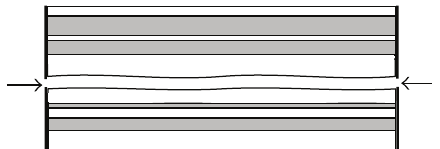
Figure 4: Layered composite material composed of orthotropic layers of constant thickness.